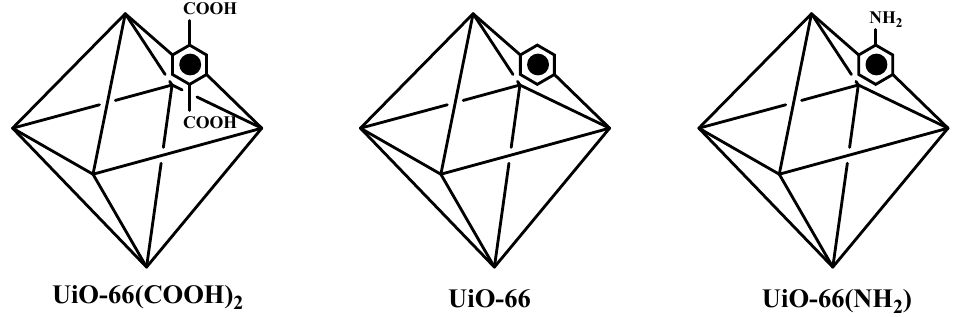
Figure 3. The suggested structures of UiO-66, UiO-66(COOH) 2 , and UiO-66(NH 2 ).